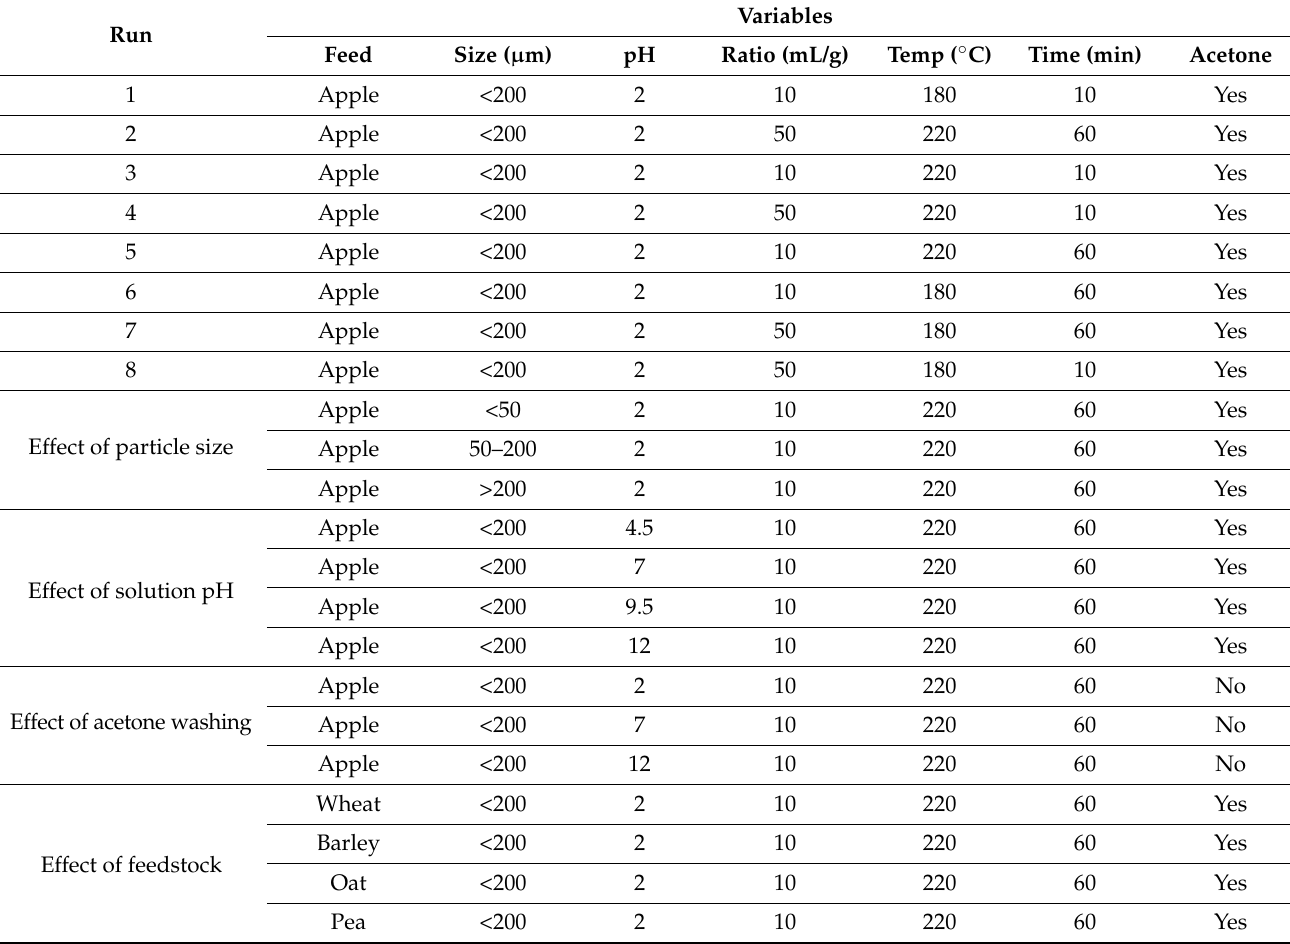
Table 1. Total experimental runs, sectioned into the effect of process conditions on apple biomass, the effect of particle size, the effect of pH, the effect of acetone washing and the effect of